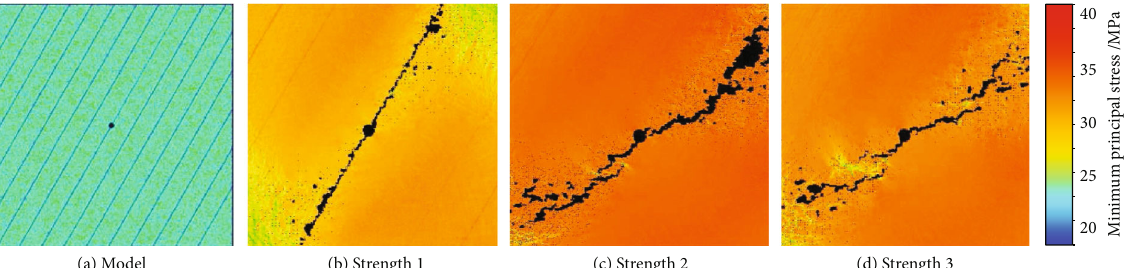
Figure 15: Fracture propagation with di ff erent bedding plane strengths [55].